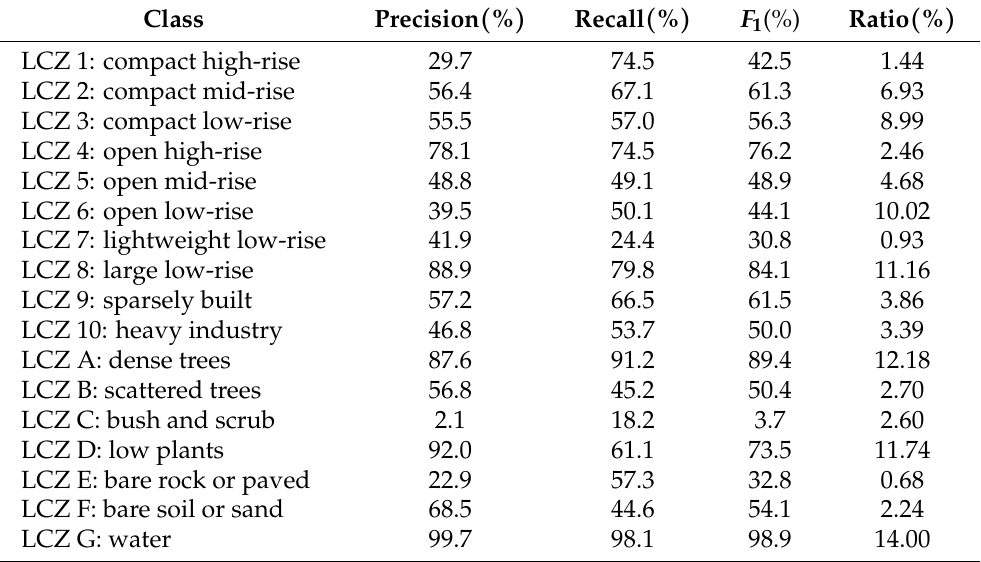
Table 3. Prediction results for each LCZ class on the test